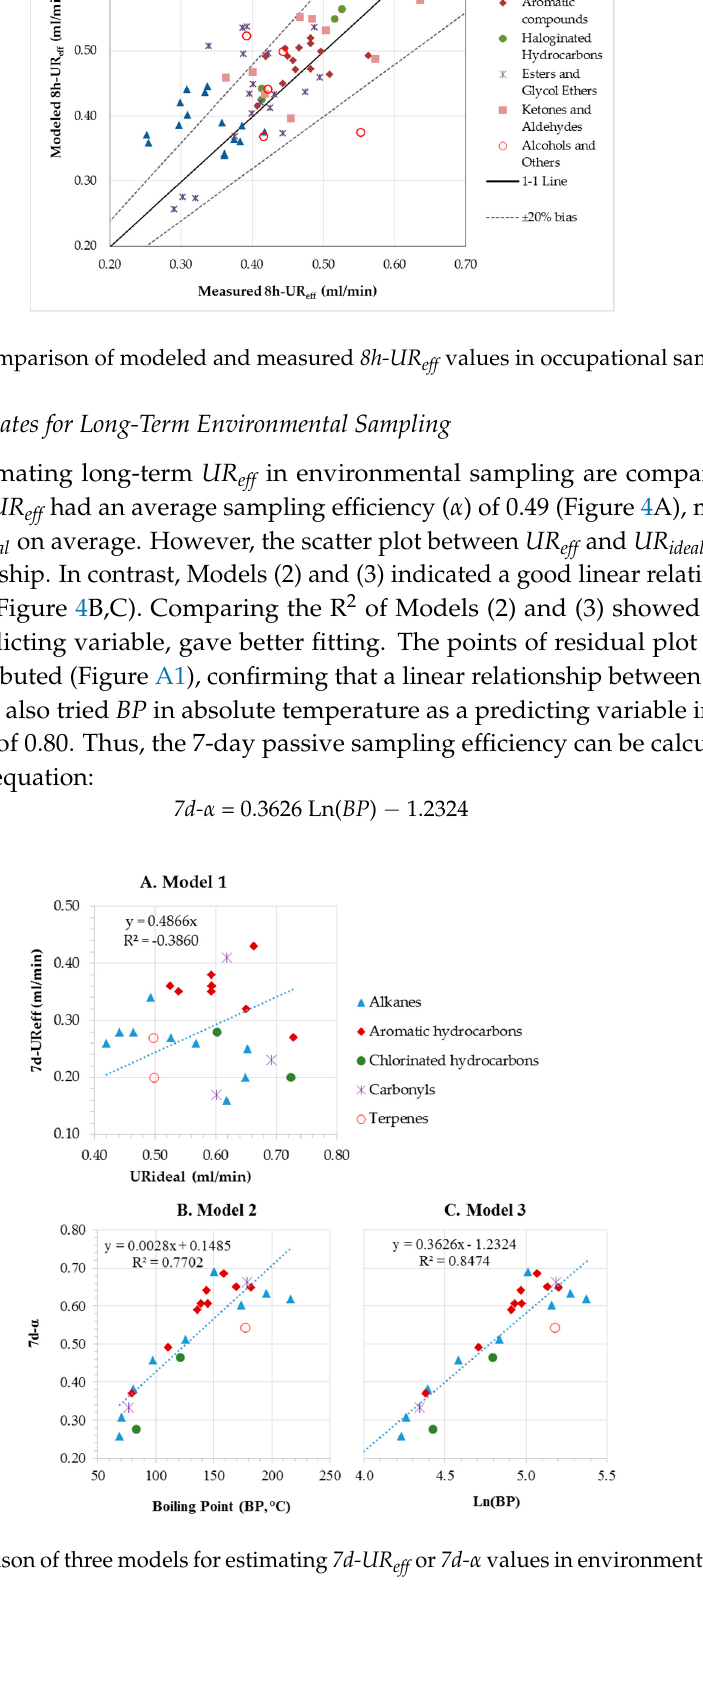
Figure 4. Comparison of three models for estimating 7d-UR eff or 7d- α values in environmental sampling.